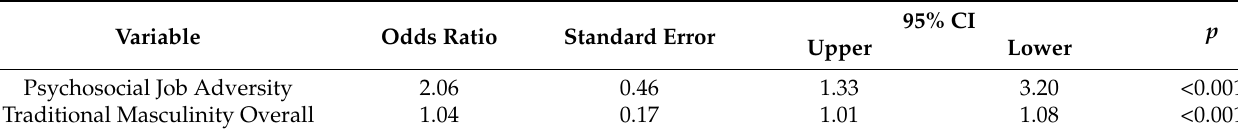
Table 2. Univariate Logistic Regression Assessing Associations between Suicidal Ideation and the Domains of Masculinity and Psychosocial Job Adversity in the ACI.